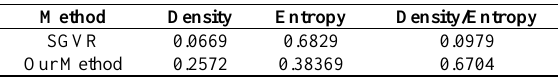
Table 2. Comparison of our method and SGVR